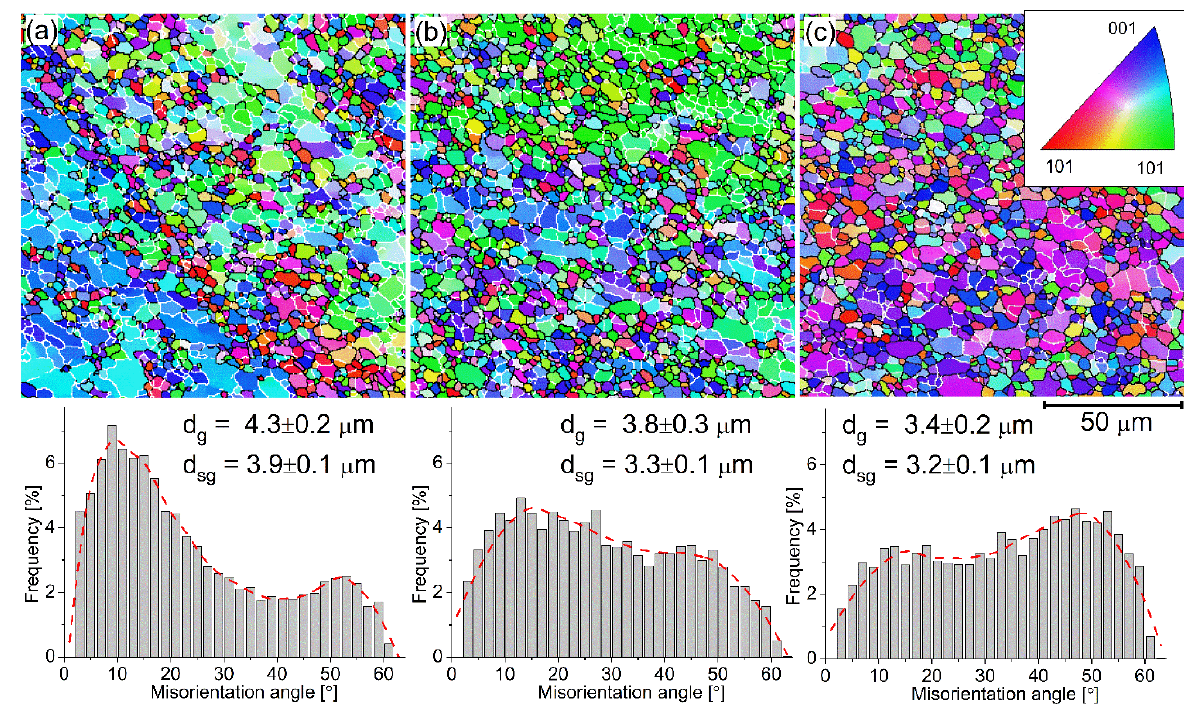
Figure 9. EBSD-IPF grain boundary maps and corresponded misorientation angle distribution histograms for the ( a ) 0Ce, ( b ) 2Ce, and ( c ) 4Ce alloys after 200% of superplastic deformation at 480 °C and 1 × 10 − 2 s − 1 strain rate.